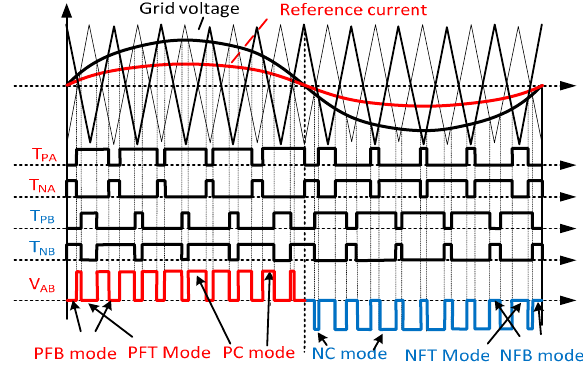
Figure 19. Principle of DFUSPWM.